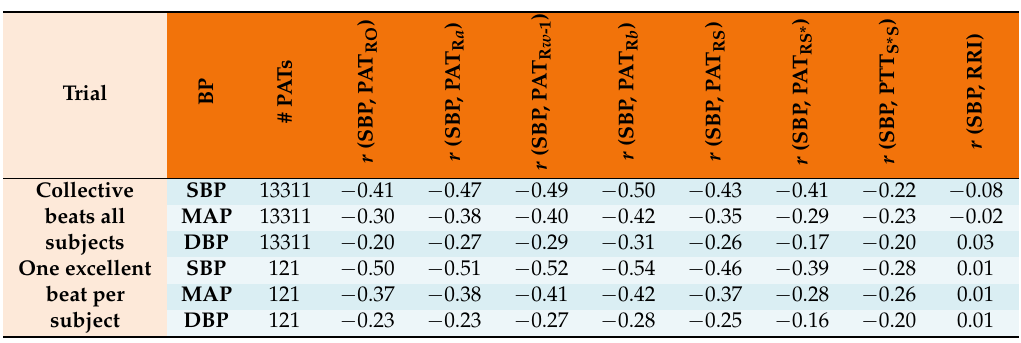
Table 5. The Pearson correlation coefficient between blood pressure and arterial wave propagation features, using total extracted beats of all subjects and one excellent beat from each subject. Note, SBP refers to systolic blood pressure, DBP refers to diastolic blood pressure, MAP refers to mean arterial pressure, PAT refers to pulse arrival time, PTT refers to pulse transient time, RRI refers to R-R interval extracted from ECG signal, and r refers to Pearson’s correlation